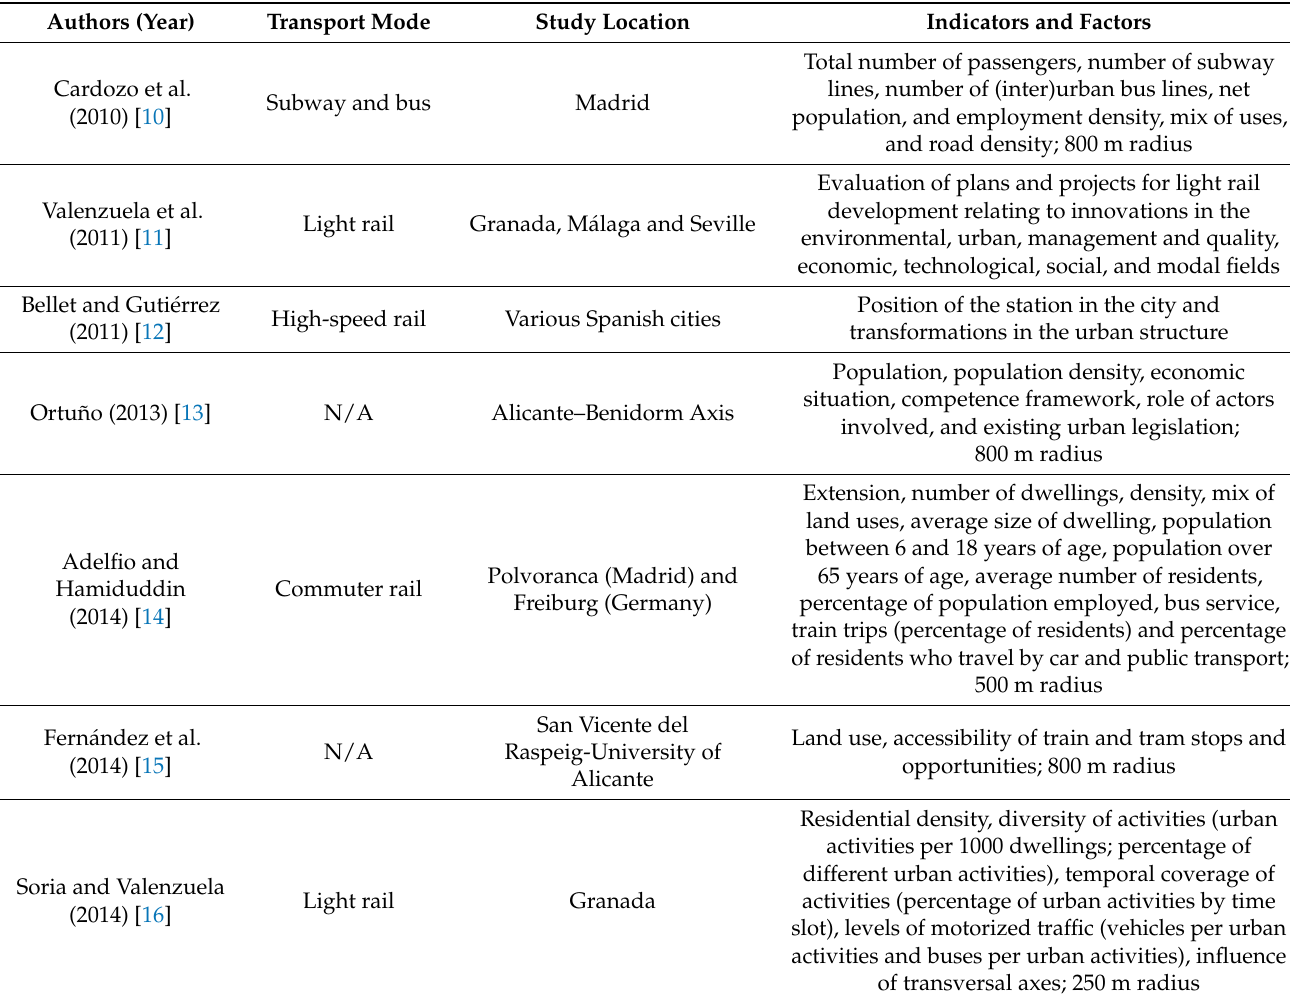
Table 1. Latest studies on TOD and the NPM in Spain since